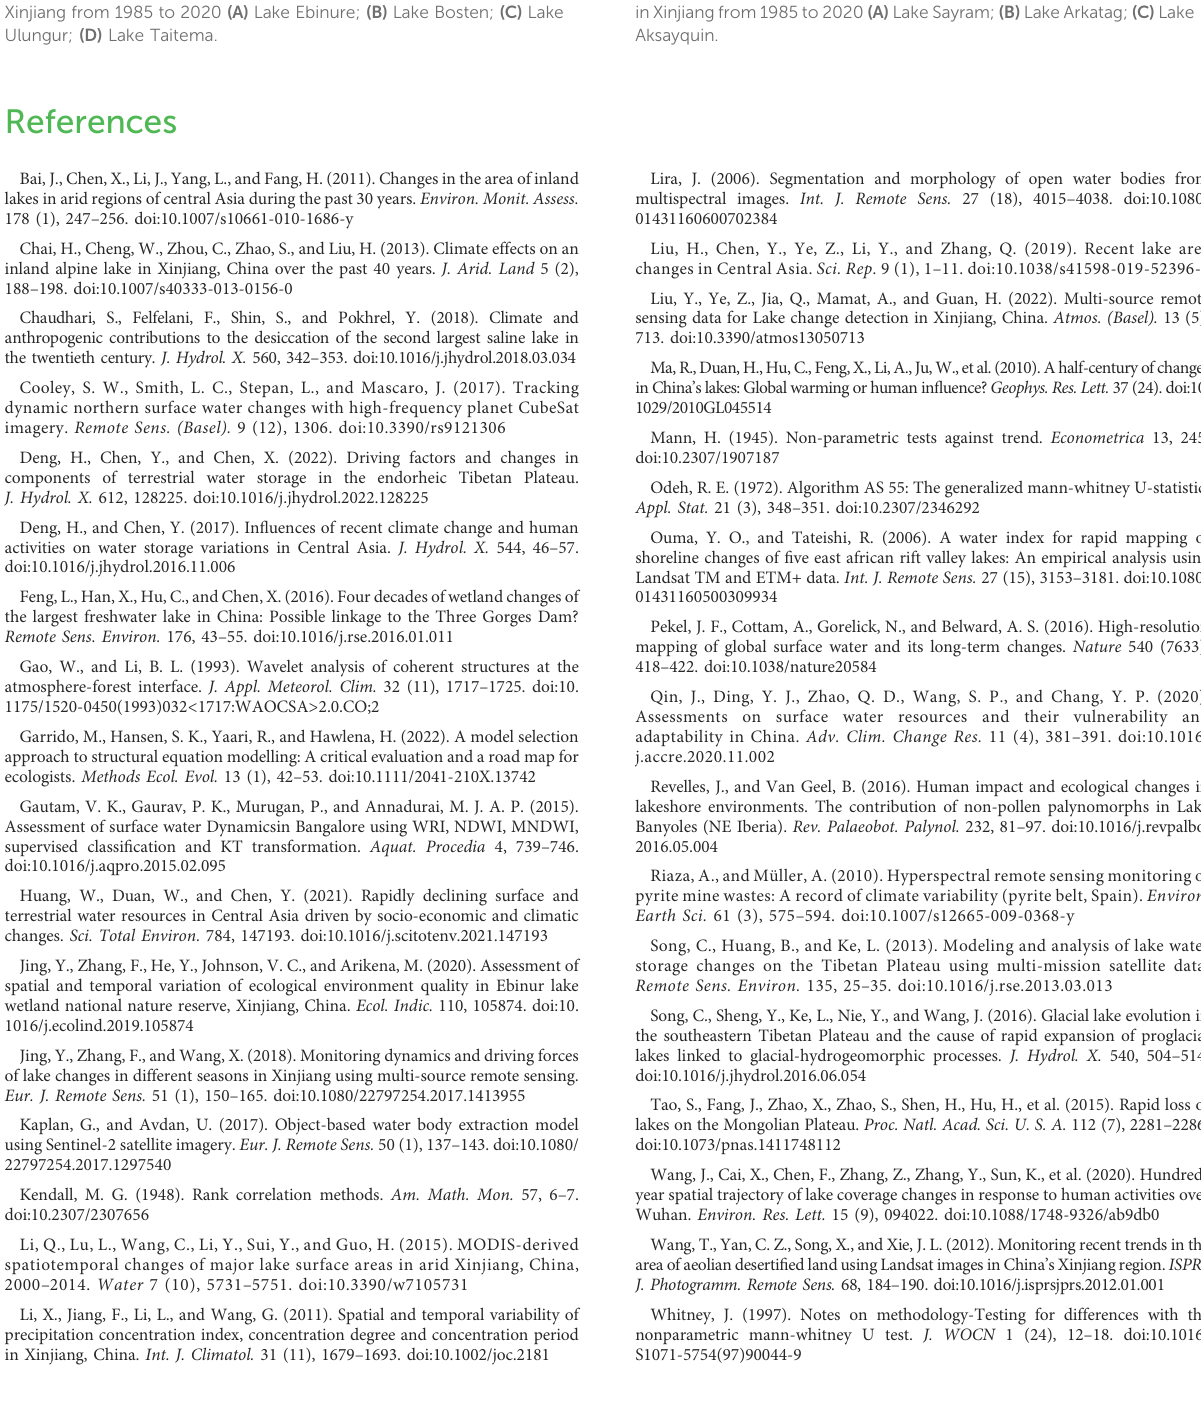
SUPPLEMENTARY FIGURE S6 Resultsof wavelet analysisof precipitation intypical mountain lake